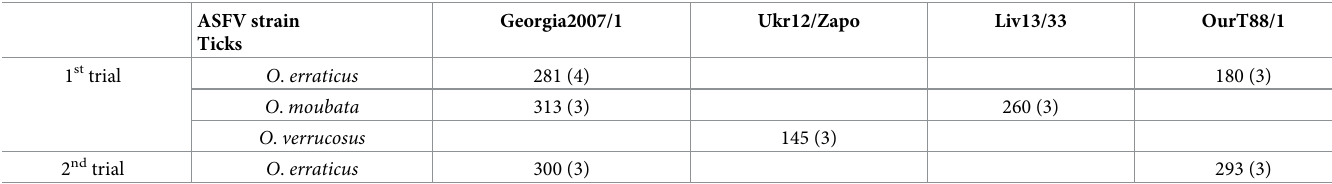
Table 1. Soft ticks fed on viremic pigs in two trials to attempt infection with four ASFV strains. Counts of engorged ticks for each Ornithodoros species tested are shown next to the number of pigs in brackets that were infected with the respective ASFV strain per trial. ASFV strain